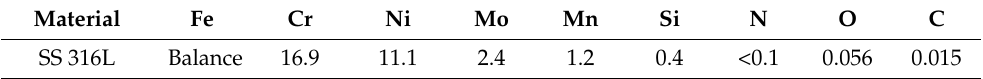
Table 1. Chemical composition of the as-received SS 316L powder material (wt. %).